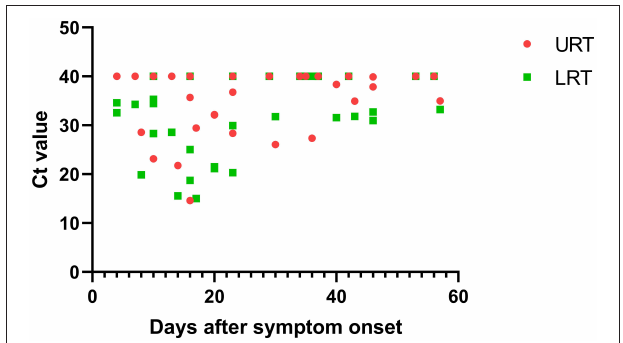
FIGURE 5 | The relationship between Ct value and days after symptom onset in the URT and LRT samples. URT, upper respiratory tract; LRT, lower respiratory tract; ICU, intensive care unit; Ct, cycle threshold.